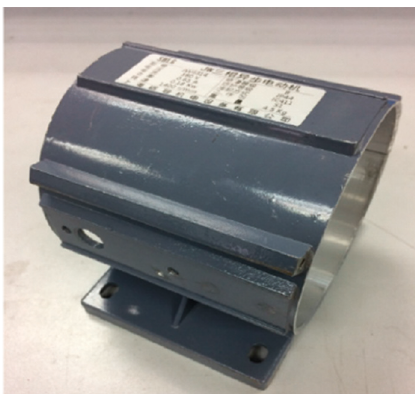
Figure 1: Aluminum alloy frame of the JW6314 motor.